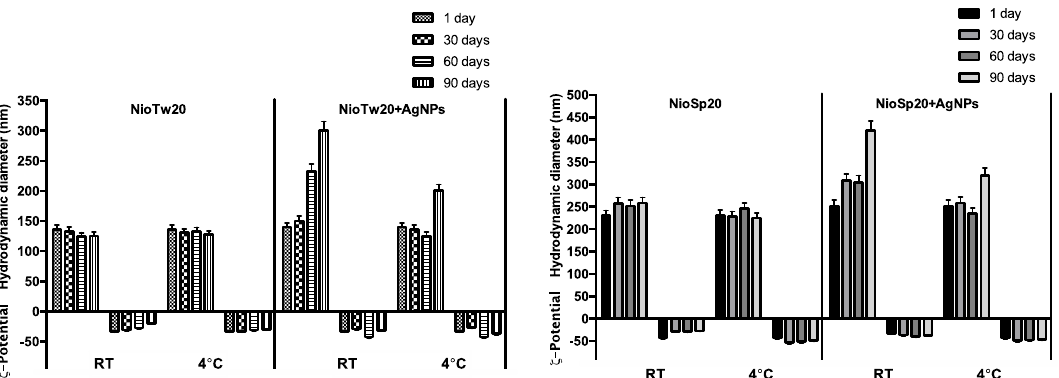
Figure 4. Stability studies of empty niosomes and Nio-AgNPs at room temperature and 4 °C.